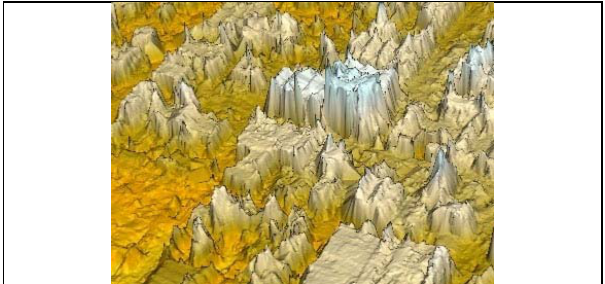
Figure 12: DSM by least squares matching